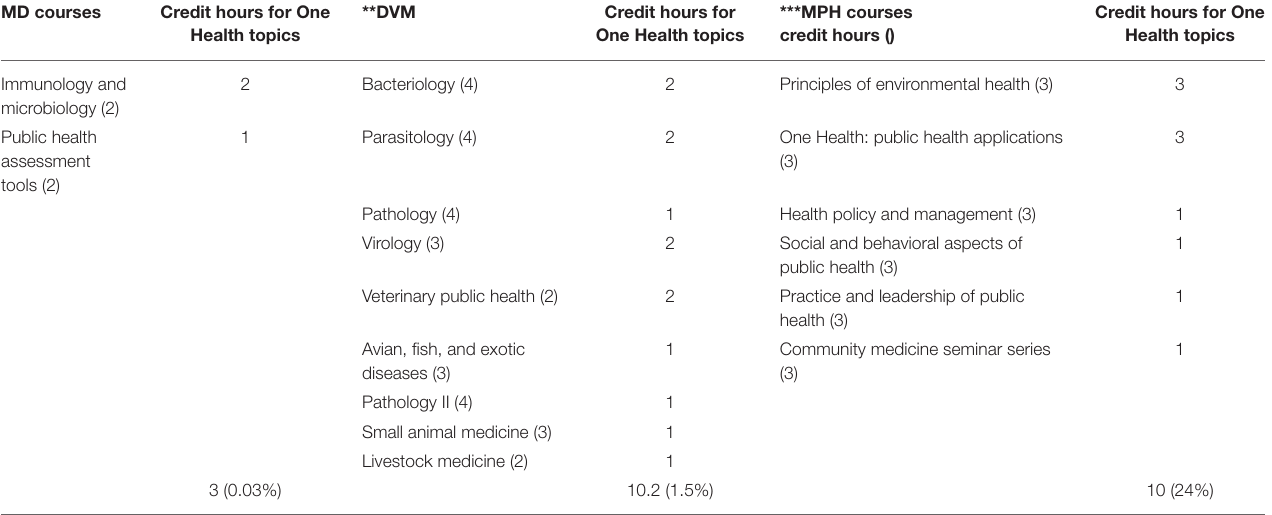
TABLE 1 | MD, DVM, and MPH curricula comparisons: credit hours for One Health topics. MD